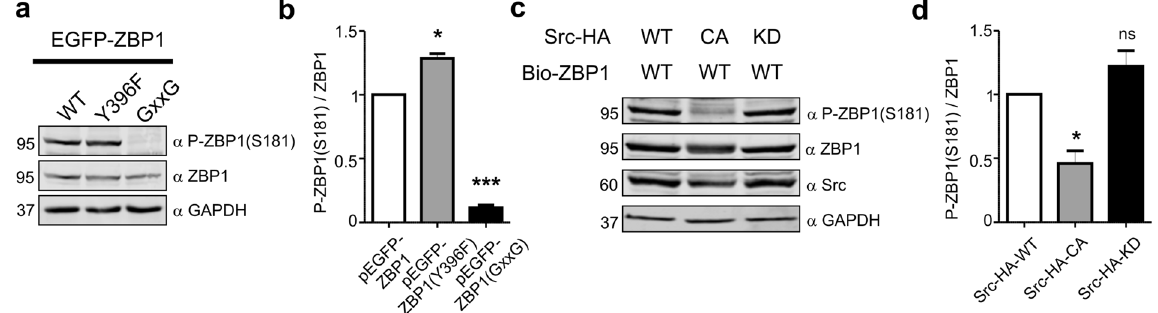
Figure 2. Serine 181 phosphorylation is dynamically regulated by Src activity. ( a) Western blot analysis of levels of ZBP1 phosphorylated at Ser181 (P-ZBP1[S181]) and total ZBP1 in protein lysates obtained from Neuro2a cells transfected with pEGFP-ZBP1, pEGFP-ZBP1 Y396F , and pEGFP-ZBP1 GxxG . GAPDH is shown as an additional loading control. Cropped blots are presented (for full length blots see Supplementary Information). ( b ) Results of quantitative Western blot analysis. The data are presented as a ratio of the signal intensity of P-ZBP1(S181) to the signal intensity of ZBP1 ± SEM. * p < 0.05, *** p < 0.001 (One sample t -test). Number of independent experiments ( N = 3). ( c ) Western blot analysis of levels of ZBP1 phosphorylated at Ser181 (P-ZBP1[S181]), total ZBP1, and Src in protein lysates obtained from Neuro2a cells transfected with pBIO-ZBP1 and plasmids that encoded Src WT , Src CA , or Src DN. GAPDH is shown as an additional loading control. Cropped blots are presented (for full length blots see Supplementary Information). ( d ) Results of quantitative Western blot analysis. The data are presented as a ratio of the signal intensity of P-ZBP1(S181) to the signal intensity of ZBP1 ± SEM. * p < 0.05, ns - non significant (One sample t -test). Number of independent experiments ( N =